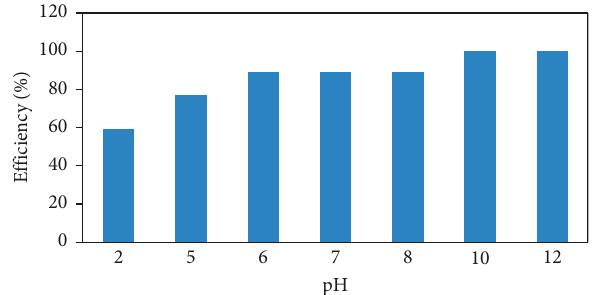
Figure 9: Effect of pH on the degradation percentage of MB.